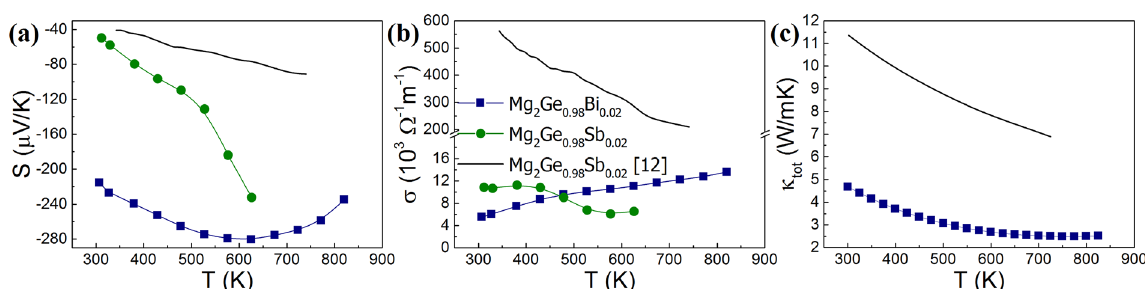
Figure 6. Temperature dependence of ( a ) the Seebeck coefficient, ( b ) the electrical conductivity, and ( c ) the total thermal conductivity of